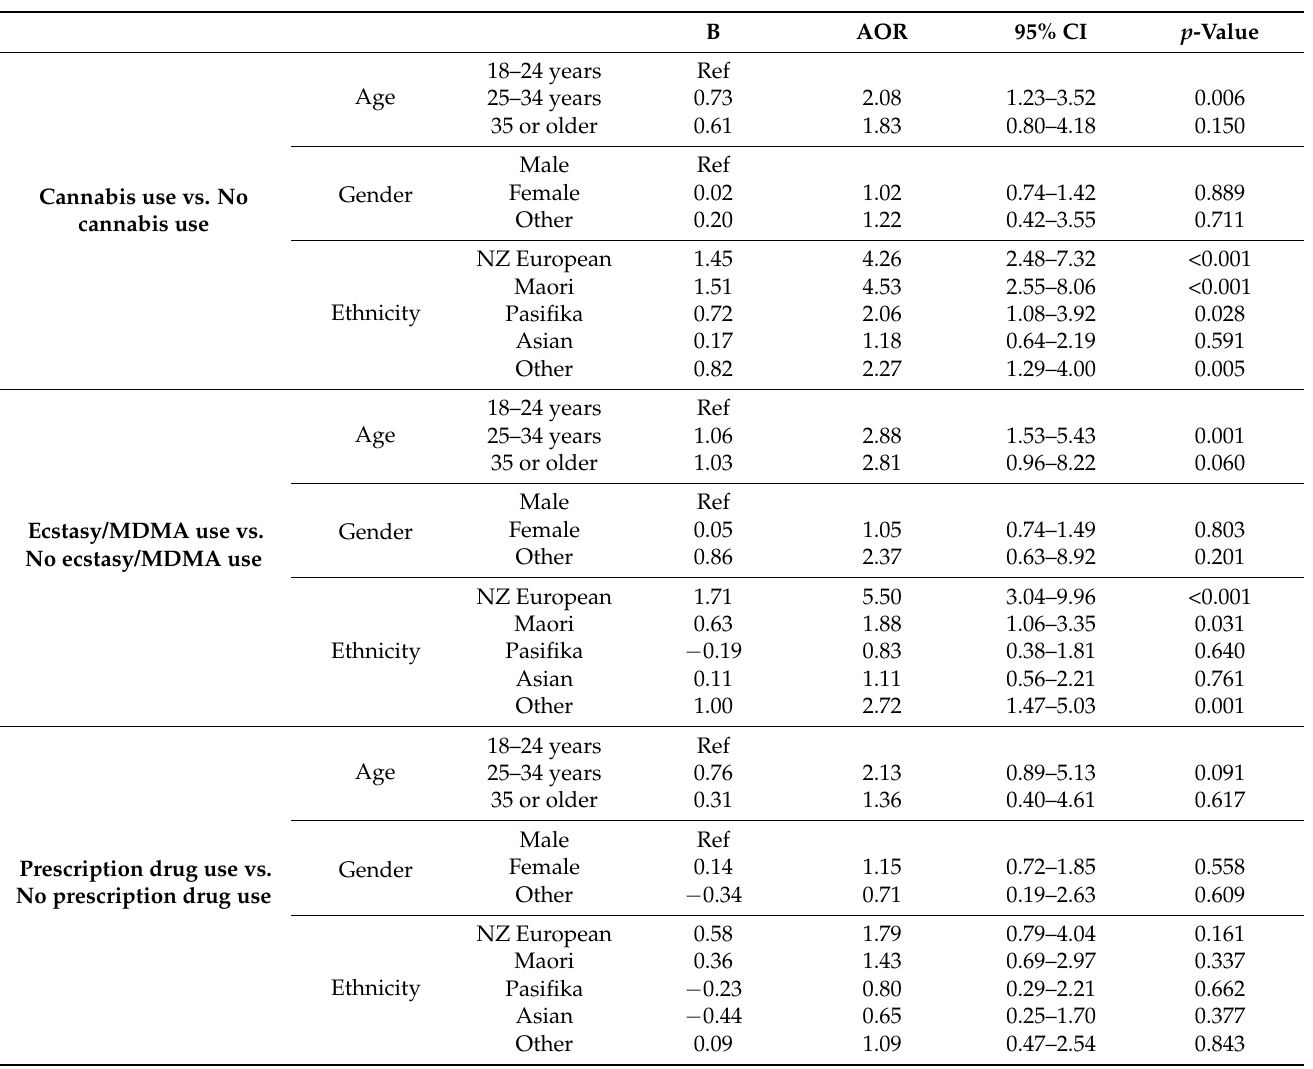
Table 5. Binary logistic models predicting the likelihood of having family/wh¯anau or close friend who used cannabis, ecstasy/MDMA or prescription drugs in a harmful way. B AOR 95% CI p